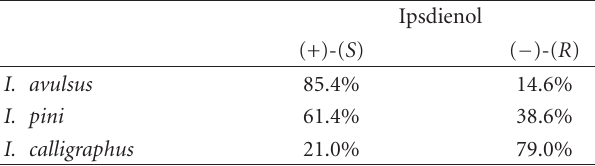
Table 5: Chiral analysis of ipsdienol in three species of